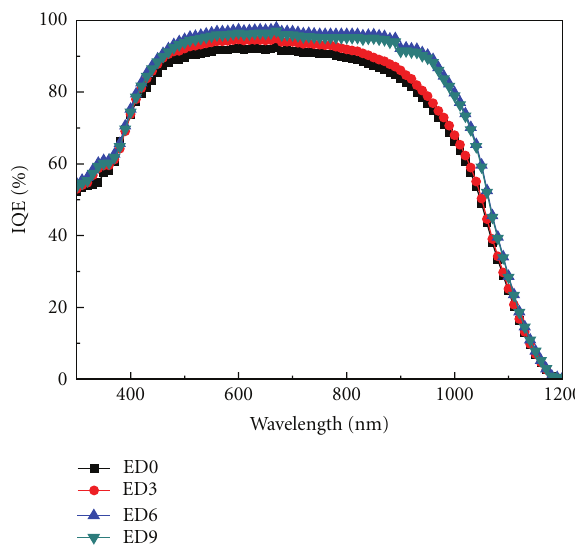
Figure 10: Internal quantum e ffi ciency (IQE) of four di ff erent etching